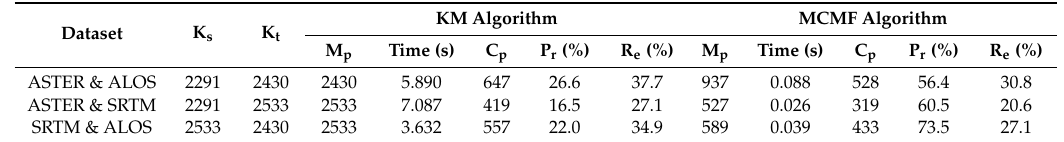
Table 5. Results of